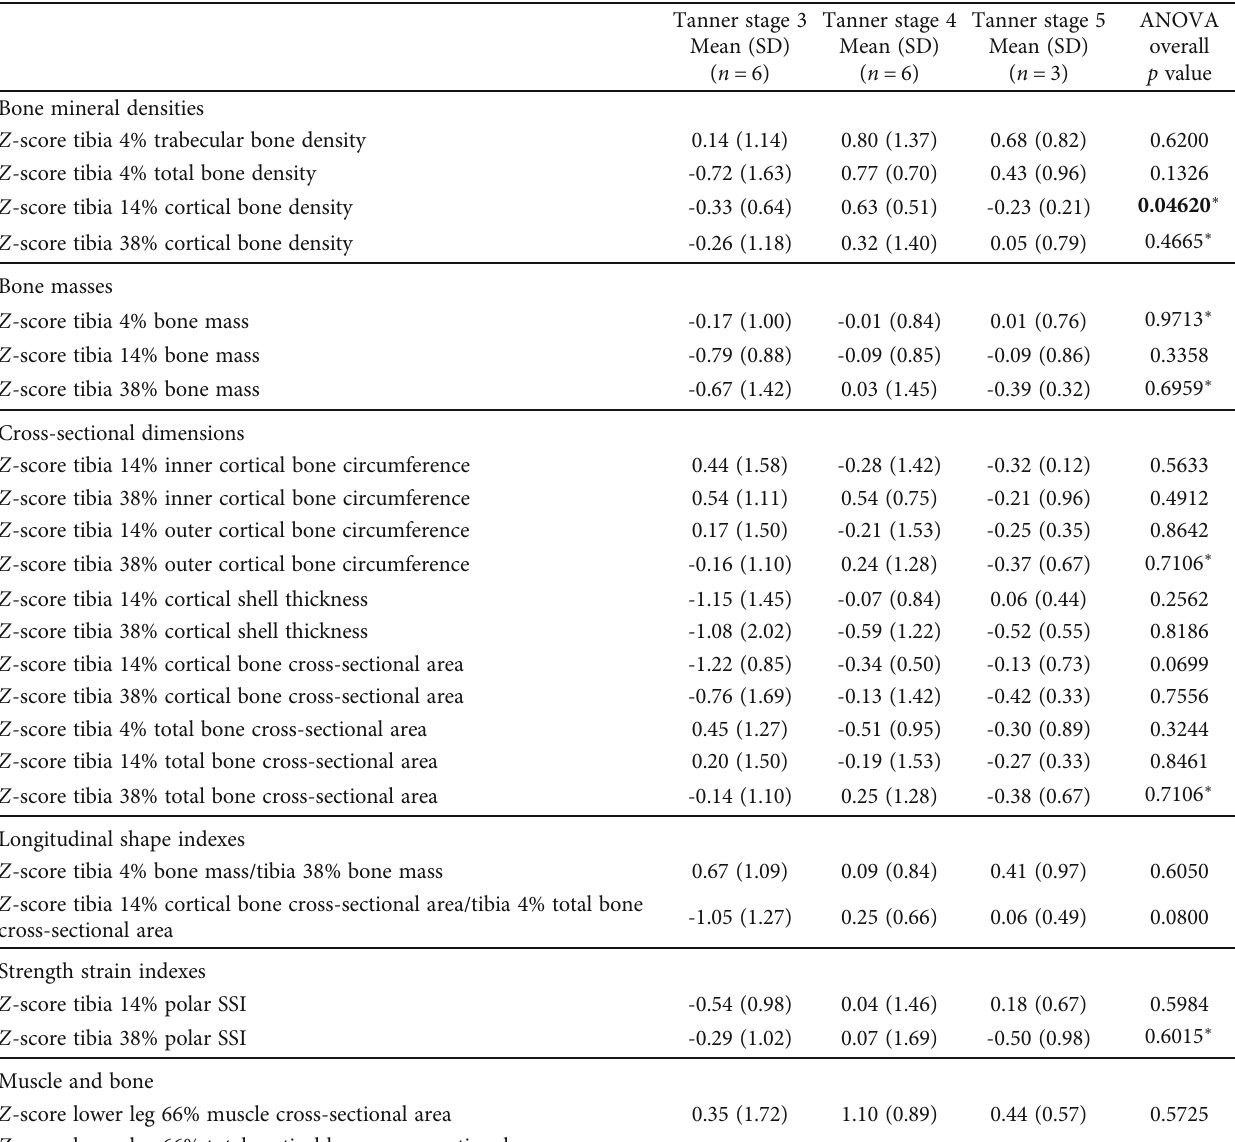
Table 4: Z -scores of pQCT outcomes by Tanner stage in